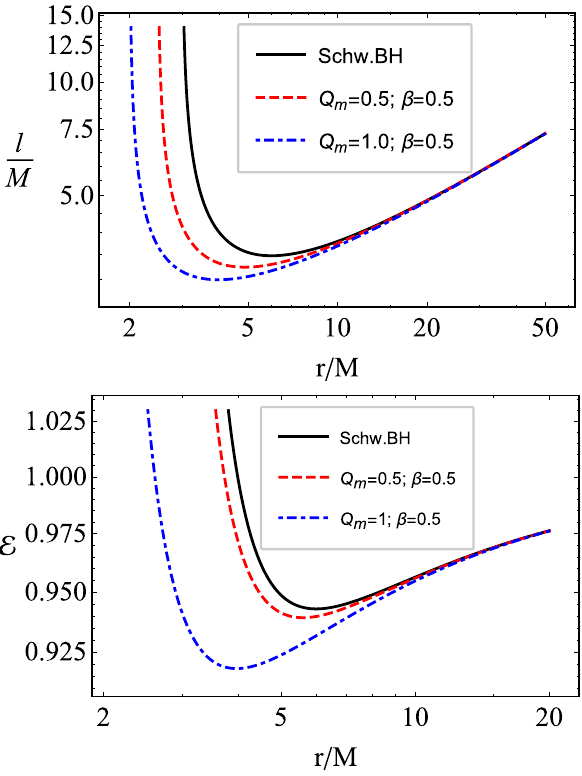
Fig. 4 The radial dependence of the specific angular momentum (top panel) and energy (bottom) for circular orbits of magnetized particles around the magnetically charged RN black hole for different values of themagneticchargeoftheblackholeandtheparameter β .Themagnetic charge reads Q m → Q m /